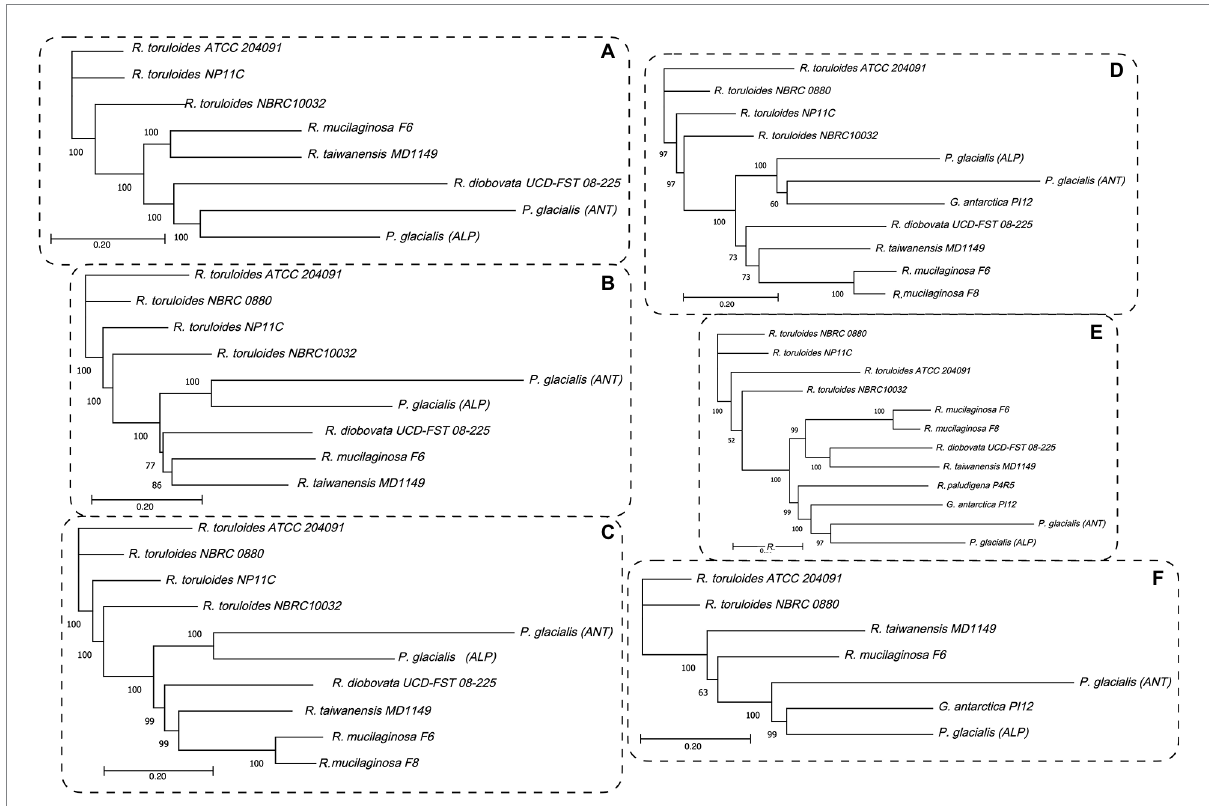
FIGURE 7 Maximum likelihood phylograms based on the concatenated CDSs. The coding sequences for proteins common to at least 8 yeasts, including both P. glacialis isolates, were concatenated and the evolutionary distances computed by Jukes-Cantor method. The phylogenetic trees obtained by neighbor-joining with 1,000 bootstrap replications and statistically supported bootstrap values ( ≥ 50%) are shown. (A) , 50 proteins common to 8 yeasts; (B) , 40 proteins common to 9 yeasts, (C) , 34 proteins common to 10 yeasts; (D) , 22 proteins common 11 yeasts; (E) , 17 proteins common to 12 yeasts. In (F) , was considered the proteins common at least for P. glacialis and G. antarctica (31 proteins, common to 7 yeasts). Abbreviation of yeasts as in Figure